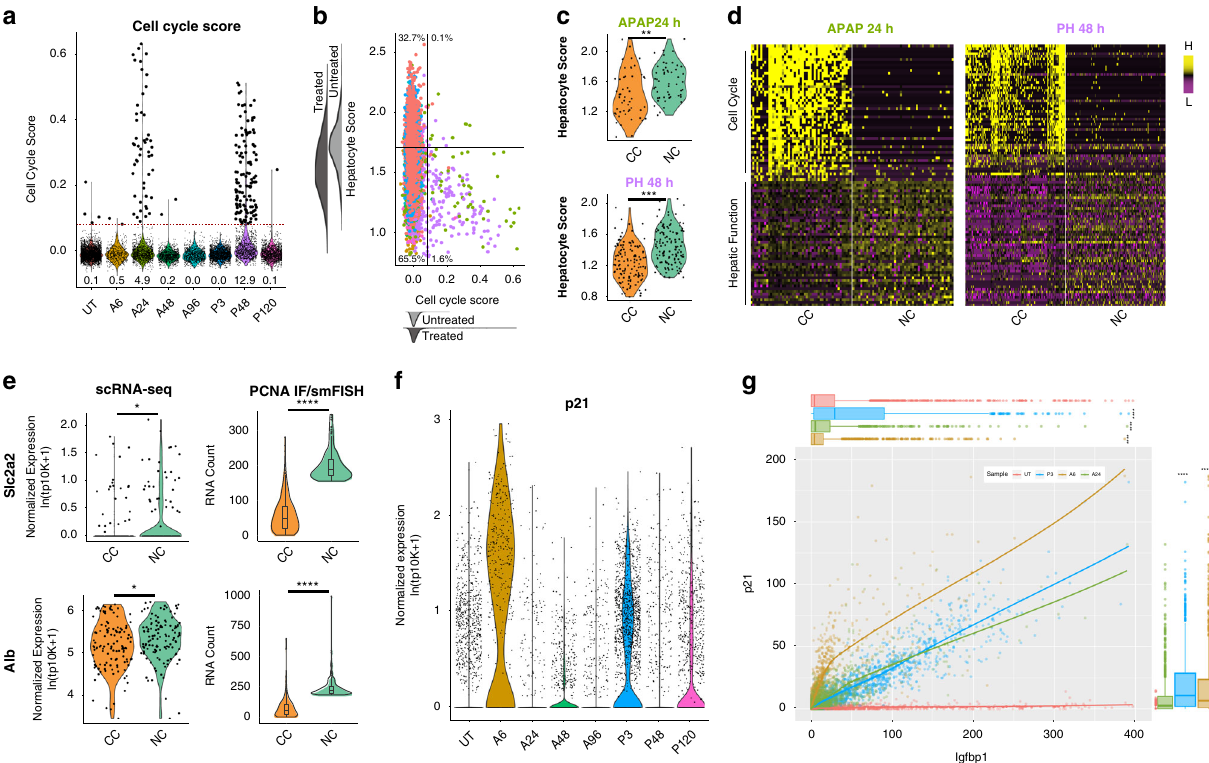
Fig. 4 Identi fi cation and characterization of proliferating hepatocytes. a Violin plot of cell cycle score across all samples. Cycling cells (CC, larger black dots) are identi fi ed as having a cell cycle score two standard deviations above average (dashed red line). Percentage of cycling cells in each condition listed below each violin. b Scatter plot of Hepatocyte Score versus Cell Cycle Score. Horizonal line represents average Hepatocyte Score calculated over all untreated cells. Vertical line represents two standard deviations above the average cell cycle score. c Violin plots on Hepatocyte Score for all APAP 24 h cycling cells (CC) and an equal number of non-cycling cells (NC) from APAP24 (top) and the same for PH48 CC and NC (bottom). scRNA-seq effect size by absolute value of Cohen ’ s d > 0.2; *, d > 0.5; **, d > 0.8; ***. d Heatmap of marker genes of CC and NC in APAP 24 h and PH 48 h. e Violin plots of Alb and Slc2a2 in CC and NC cells as measured by scRNA-seq (left) and by co-staining of PCNA and smFISH within tissue sections from P24 (right). scRNA- seq effect size by absolute value of Cohen ’ s d > 0.2; *, d > 0.5; **, d > 0.8; ***. smFISH data tested using an unpaired t test with Welch ’ s correction (two- tailed; ****, P < 0.0001). f Violin plot of p21 expression in scRNA-seq dataset. g Quanti fi cation of RNA counts of p21 versus Igfbp1. Box plots represent data for both axes. Source data provided as a Source Data fi